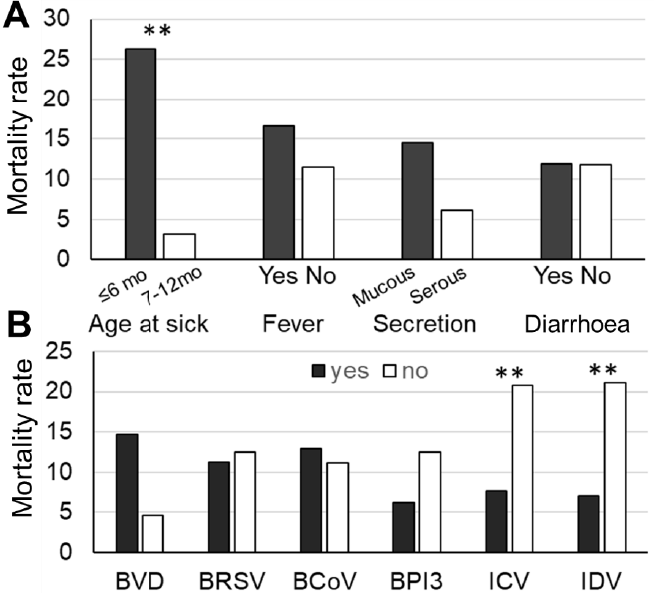
Figure 1. Comparisons of mortality rates of bovine respiratory disease (BRD) calves between with and without factors ( A ) and virus detection ( B ). * and ** indicate different culling rates at p < 0.10 and p < 0.05, respectively. BVDV: bovine viral diarrhoea virus; BRSV: bovine respiratory syncytial virus; BCoV: bovine coronavirus; BPIV-3: bovine parainfluenza virus 3; ICV: influenza C virus; IDV: influenza D virus.